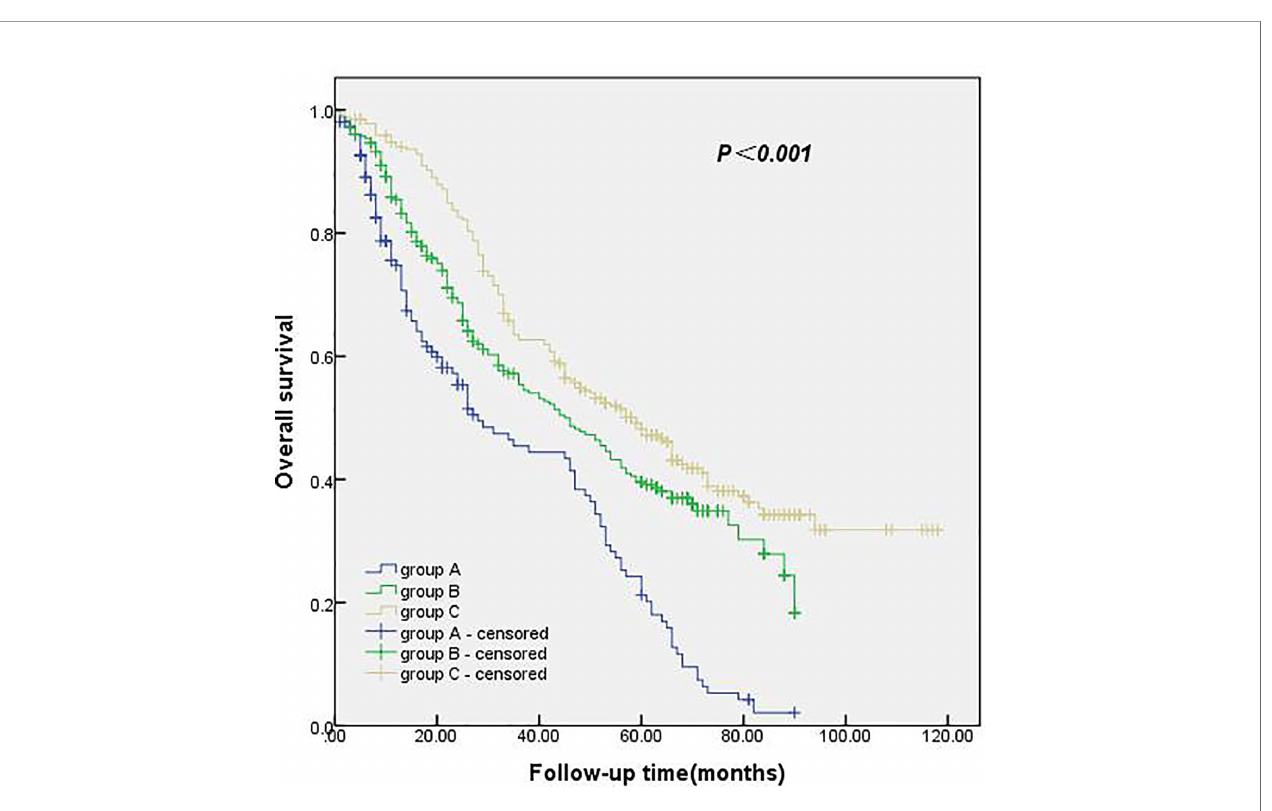
FIGURE 2 | Kaplan-Meier survival curves for group A, B and C.